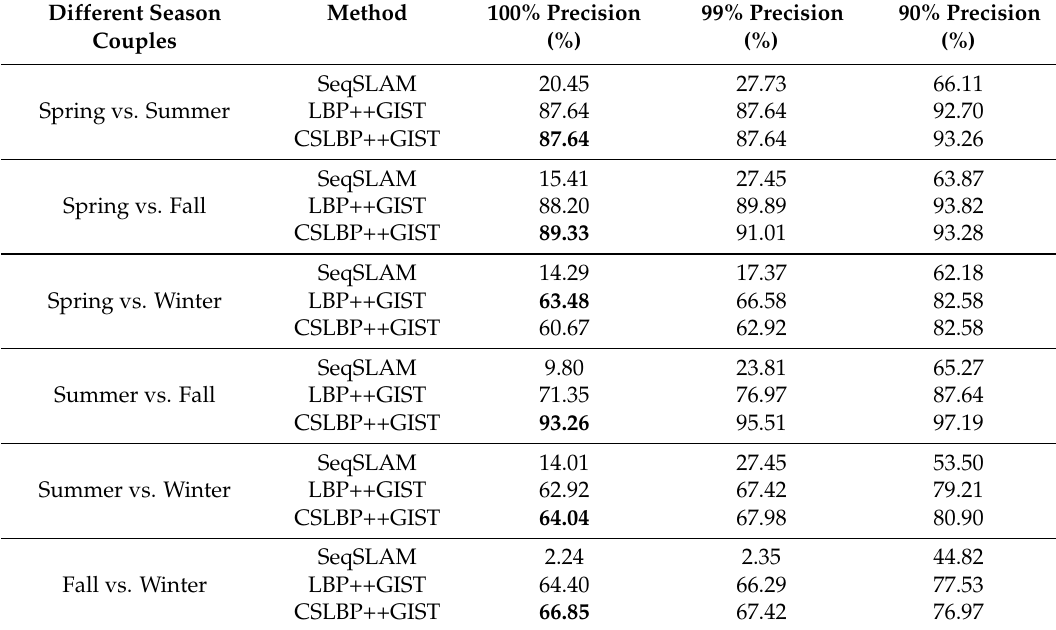
Table 1. Recall scores at selected high precision levels (100%, 99%,